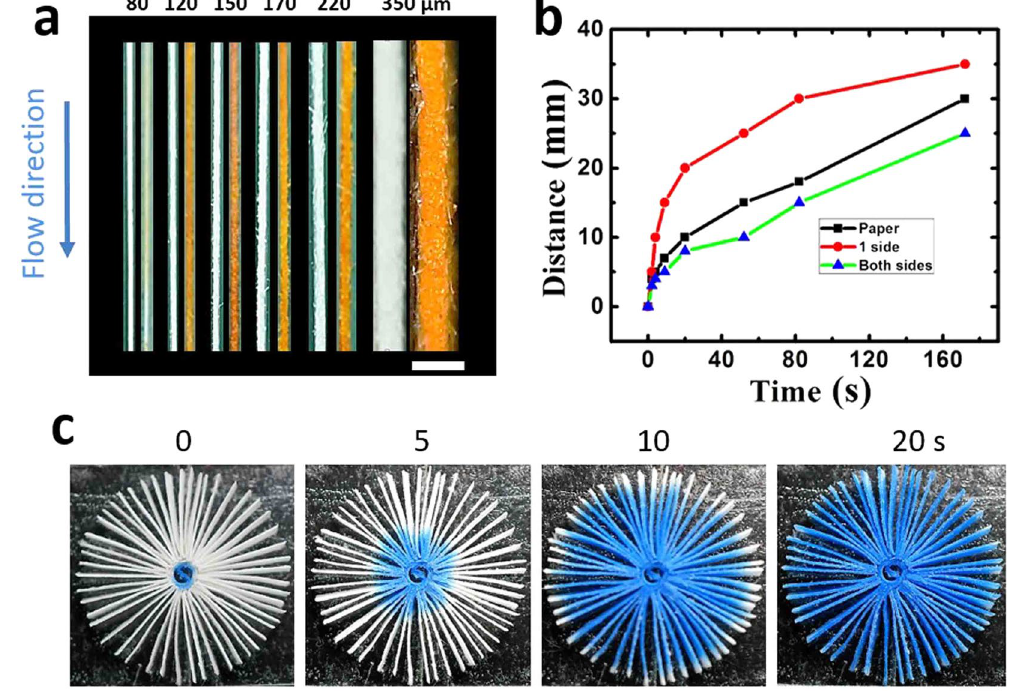
Figure 2. ( a ) Photographs of paper channels fabricated using paper stirps with different widths before and after introduction of an aqueous solution containing 10 mM methyl orange. The width of the paper strips are indicated. ( b ) Distance travelled by the solution as a function of time for different paper channels. ( c ) Photographs of a vPAD device after introduction of an aqueous solution containing 10 mM coomassie brilliant blue.